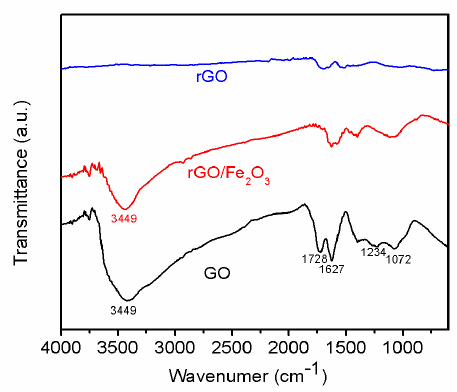
Figure 6. FTIR spectra of GO, r-GO/ Fe 2 O 3 , and r-GO.